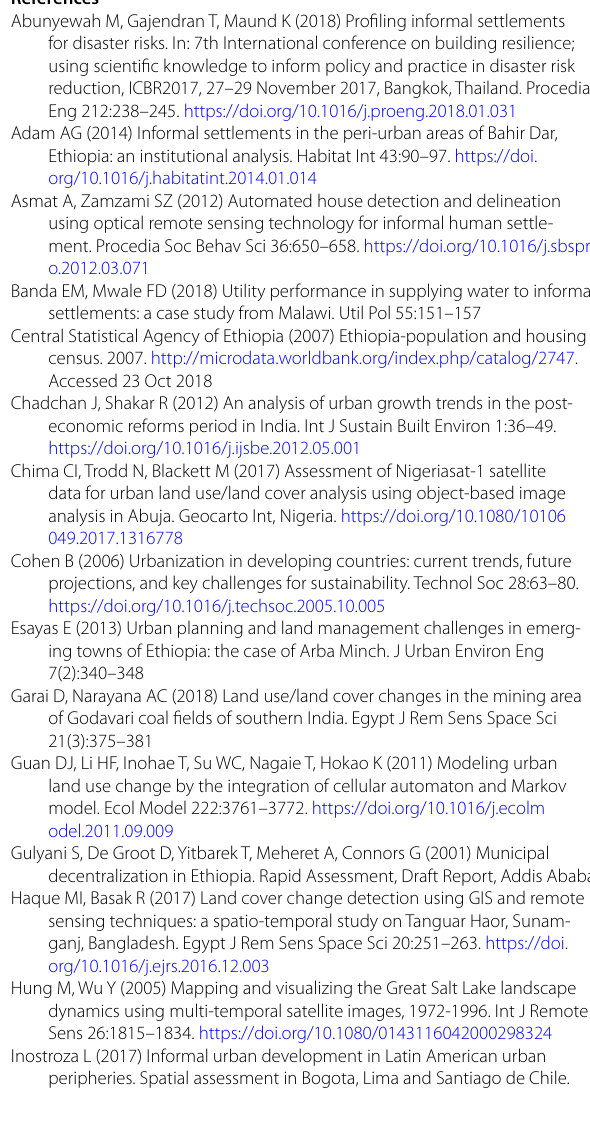
Fig. 8 Impacts of informality from informal settler’s point of view (Source: Field Survey